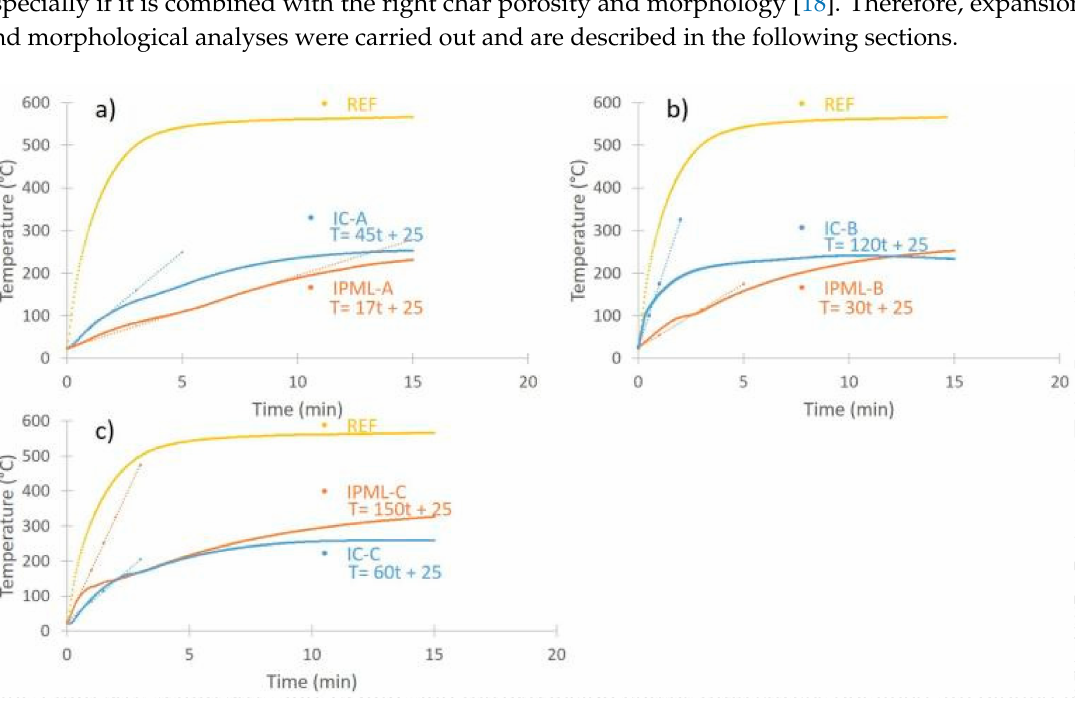
Figure 6. Evolution of temperature versus time for each system (( a ) Temperature vs. time for A system, ( b ) Temperature vs. time for B system, ( c ) Temperature vs. time for C